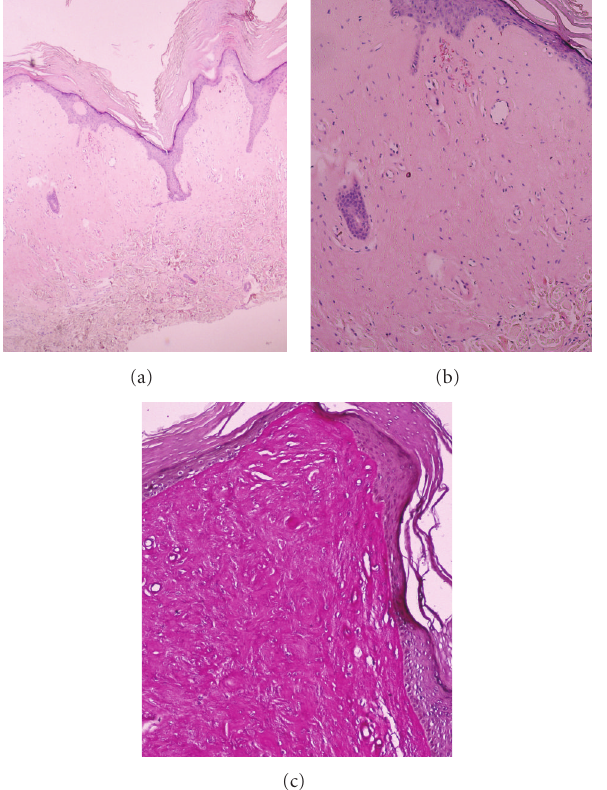
Figure 3: Histological features of LP (a) Epidermal hyperkeratosis and accumulation of hyaline material in dermis (H and E x 40). (b) A skin biopsy was performed from the hyperkeratotic plaque on the right elbow, revealing epidermal hyperkeratosis, eosinophilic, amorphous, infiltrate throughout the dermis and thickening of basement membrane (Figures 3(a) and 3(b)). The infiltrate showed strong staining with periodic-acid Schi ff (PAS (+)) (Figure 3(c)).